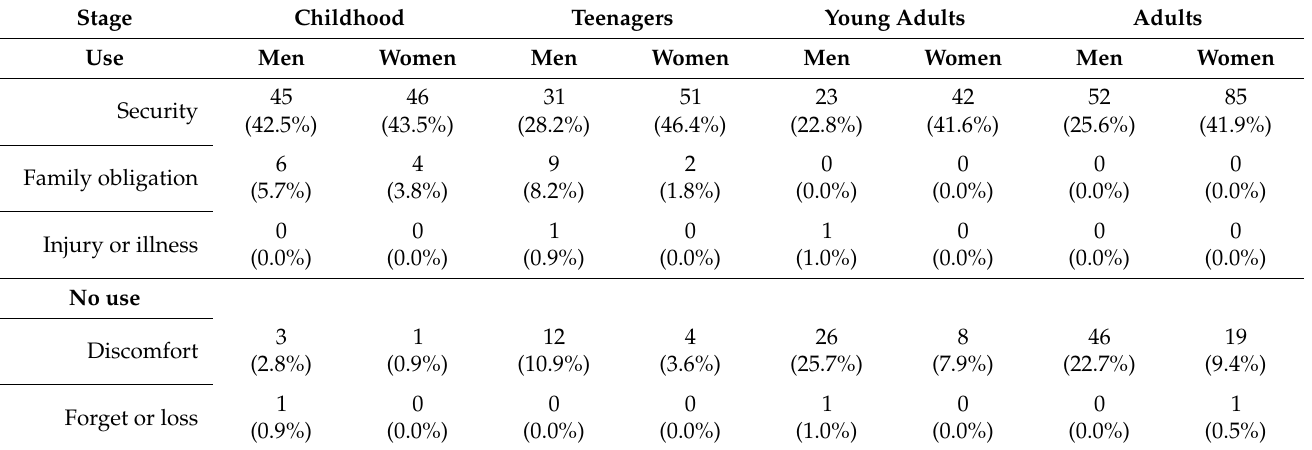
Table 1. Reasons why to use/not use protection regarding development stage and gender.